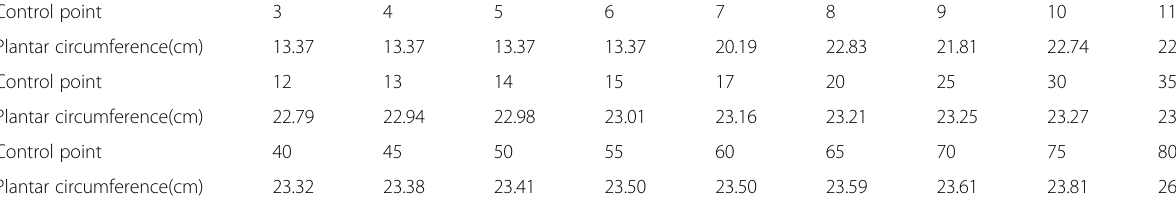
Table 1 The relationship between the number of control points and the length of the metatarsale girth Control point